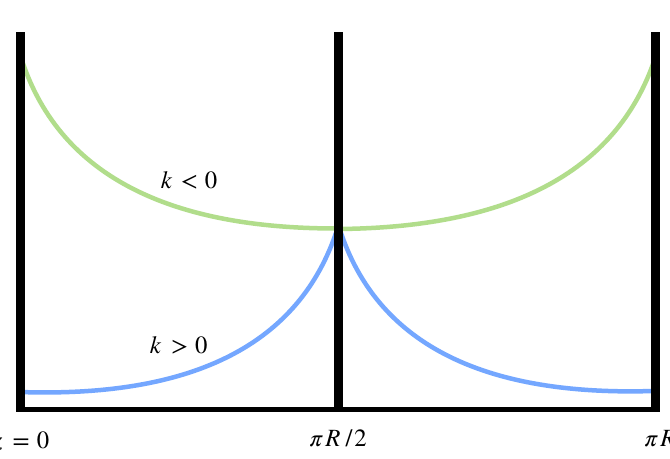
Figure 2 . Graphical depiction of the warp factor e 2 σ ( z ) in the IR-UV-IR (blue) and the UV-IR-UV (green)